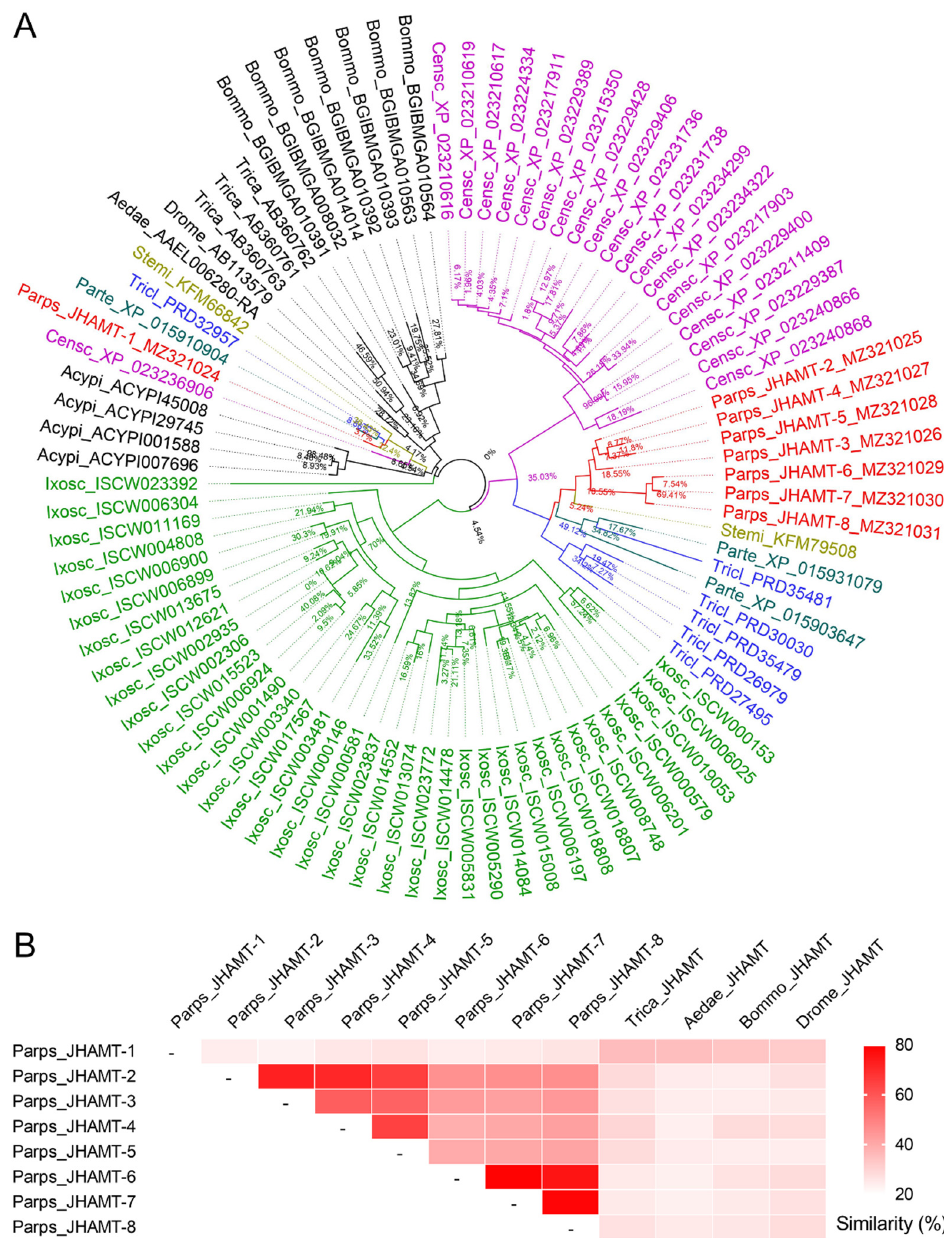
Figure 3. Phylogenetic analysis ( A ) and similarities ( B ) of JHAMTs from arachnids and